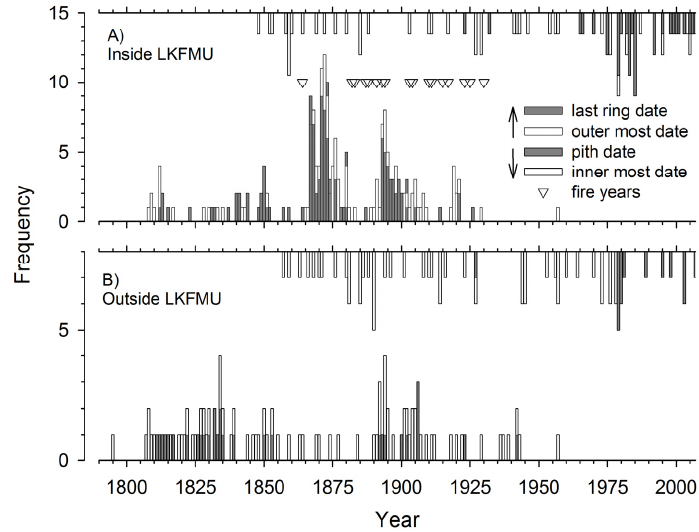
Figure 5. Age structure distribution of Pinus banksiana trees sampled within ( A ) and outside ( B ) Lake Katherine Fire Management Unit (LKFMU). The location of sampling sites located inside and outside of LKFMU can be seen in Figure 1D. For the age structure ( A and B ), the bottom bars are associated with recruitment whereas the top bars are associated with mortality. The frequency of trees with the pith date (bottom bars in A and B ) and with the last ring complete (upper bars in A and B ) are gray, whereas the white ones indicate the innermost and outermost dates. In LKFMU, jack pine trees recorded their first scar at a mean diameter of 4.3 cm at cross ‐ section height (standard deviation: 2.33, range 1.07–15.00, n = 93) and at a mean age of 20.61 years (standard Forests 2016 , 7 , 219